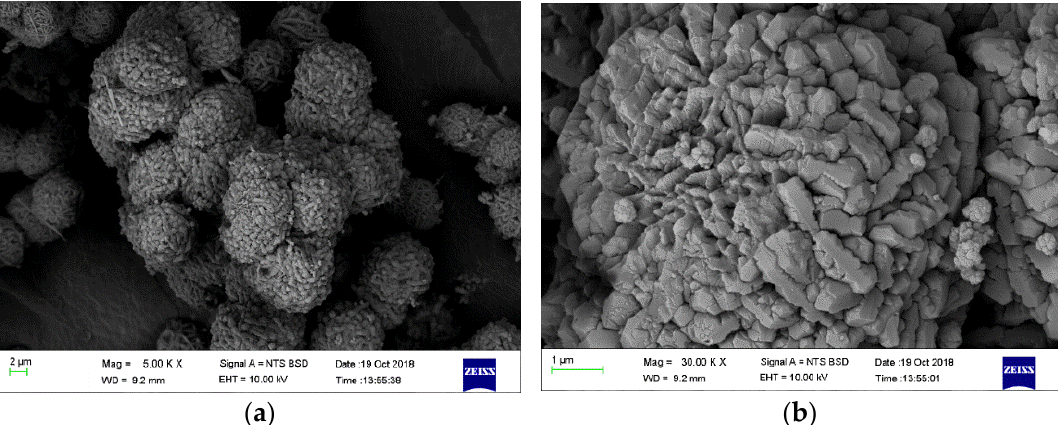
Figure 2. Surface morphology of hydroxy sodalite: ( a ) low magnification (5000× magnification (5.00 kx) and ( b ) high magnification (50,000×).